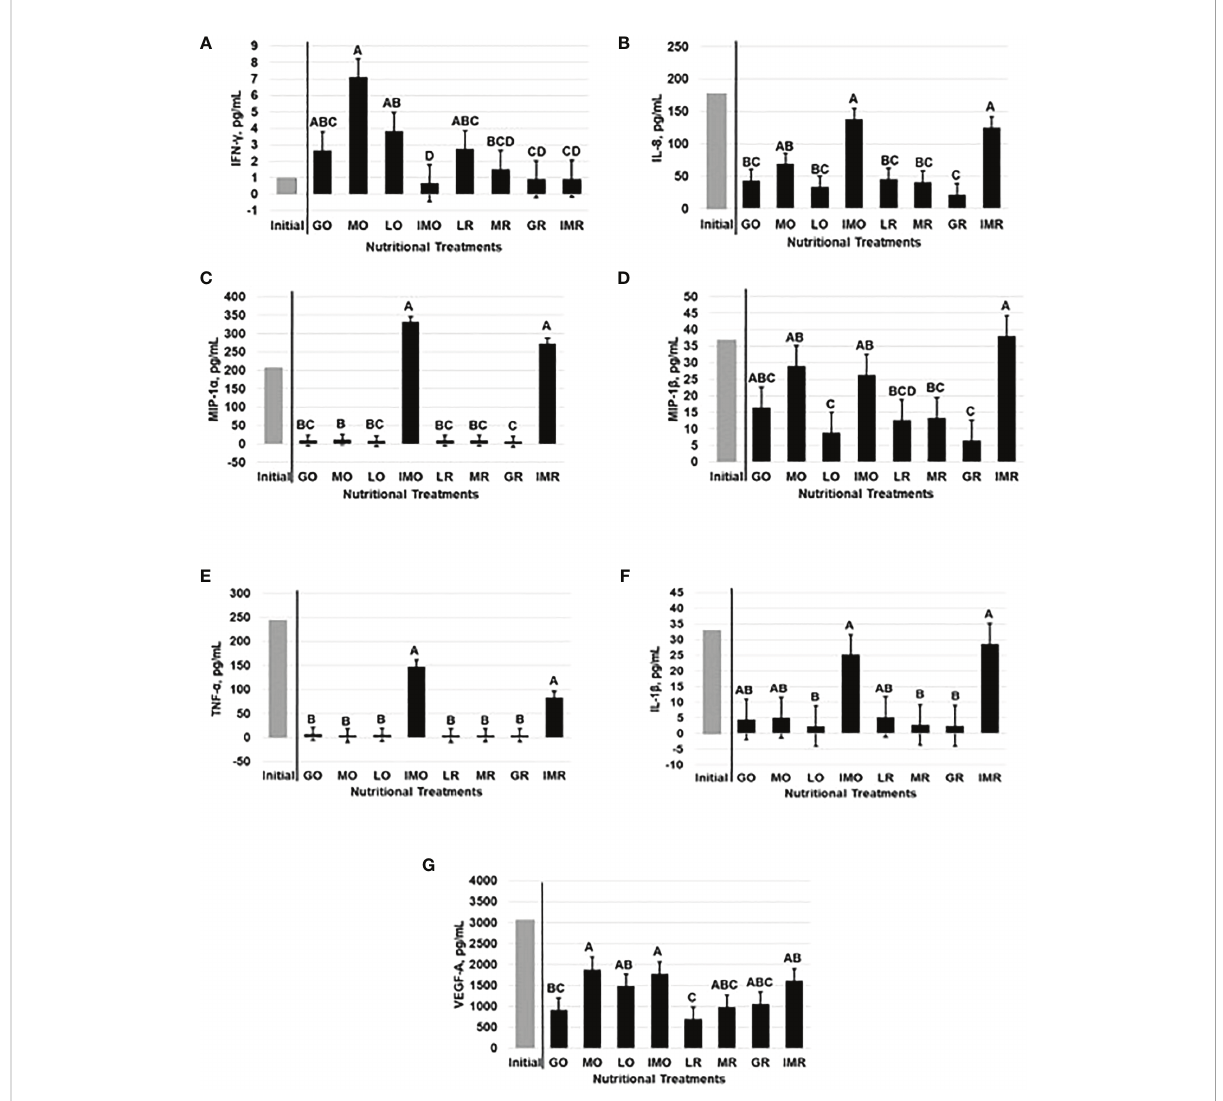
FIGURE 2 Seminal plasma concentrations (n=11; Least Square Mean ± SEM) of IFN- g (A) , IL-8 (B) , MIP-1 a (C) , and MIP-1 b (D) TNF- a (E) , IL-1 b (F) , and VEGF-A (G) were affected by nutritional treatments. ABCD Bars that do not share a letter denotes differences at P ≤